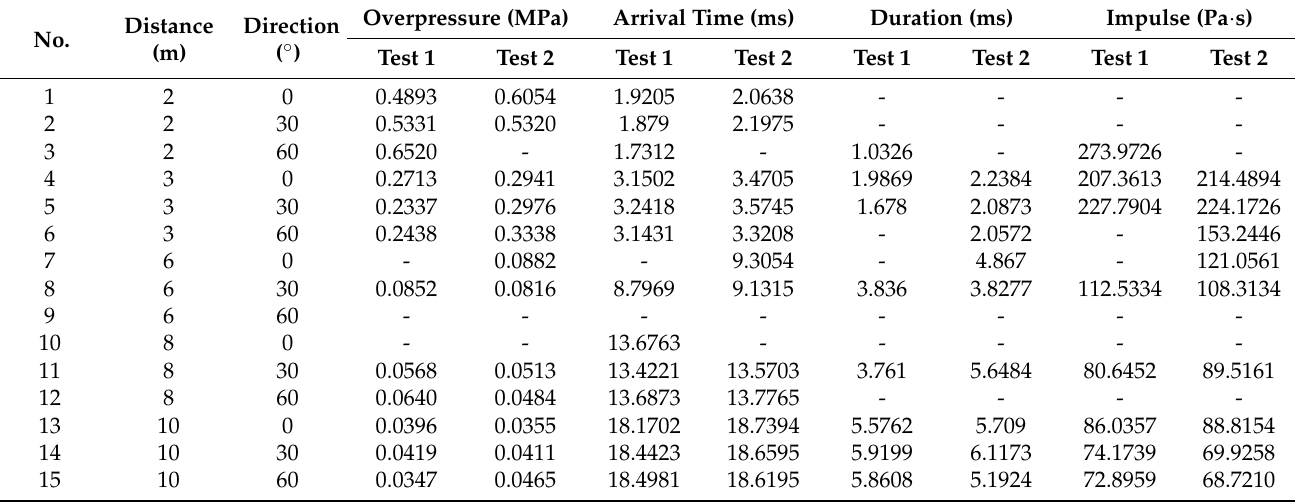
Table A1. Shock wave parameters of two stationary charge explosion